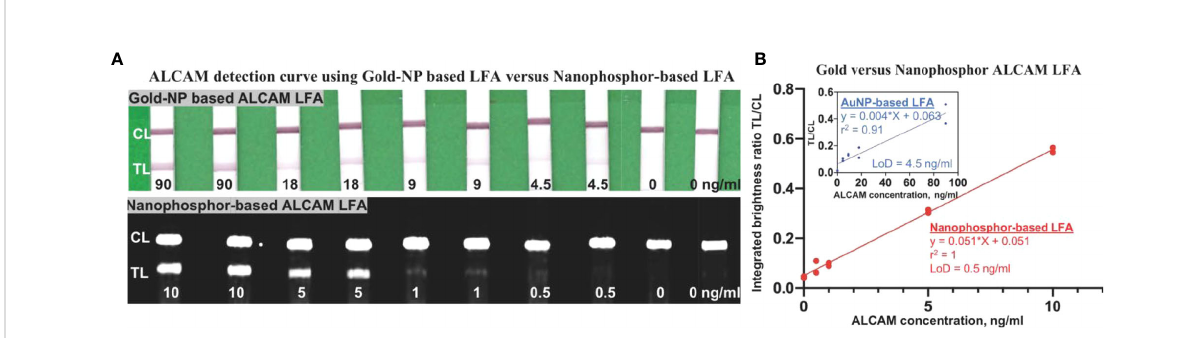
FIGURE 2 Comparison of ALCAM detection by nanophosphor- and AuNP-based LFA. (A) Scanned images of LFAs of dilution series of ALCAM using AuNPs and nanophosphors. The AuNPs-based LFA used pAb-1A as capture antibody and mAb-2A as detection antibody, and the SAOs-based LFA used pAb-1A as capture antibody and mAb-1A as detection antibody. (B) The correlation between ALCAM concentration and integrated brightness ratio as assayed using AuNP-LFA (inside box) and nanophosphor-based LFA. pAb-1A, polyclonal anti-ALCAM antibody from R&D; mAb-1A, monoclonal anti-ALCAM antibody from R&D; mAb-2A, monoclonal anti-ALCAM antibody from Bio-legend; detection Ab, the antibody conjugated onto the SAOs; capture Ab, the antibody immobilized onto the LFA strip; LoD, limit of detection, the lowest concentration exceeding the sum of the mean of the blanks (n=2) plus three times the standard deviation of the blanks.